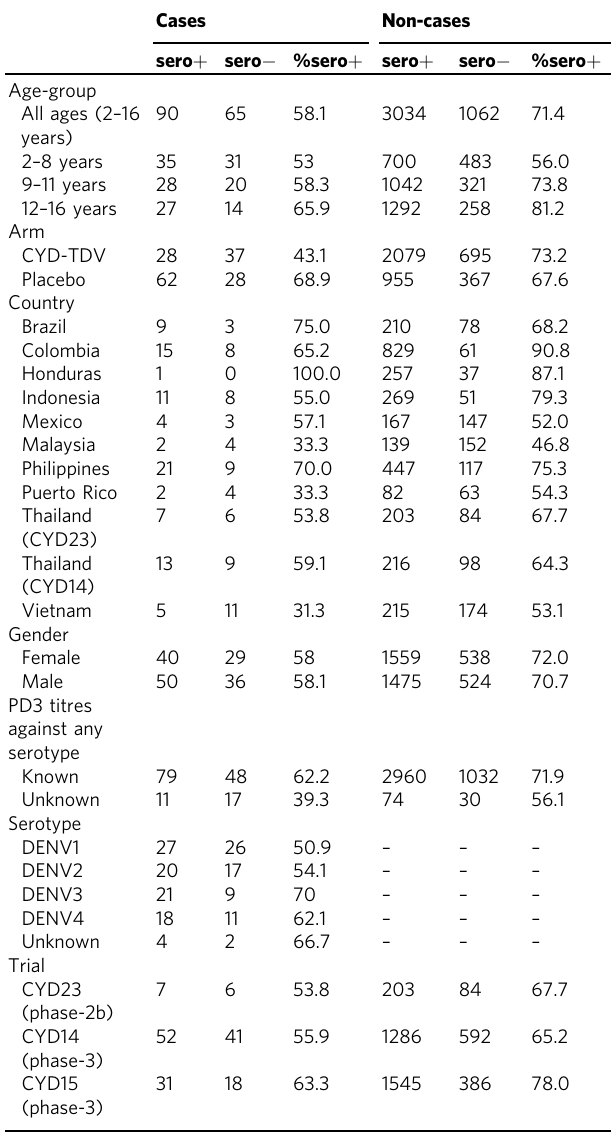
Table 1 Summary of dengue exposure among cases and non- cases with known baseline serostatus